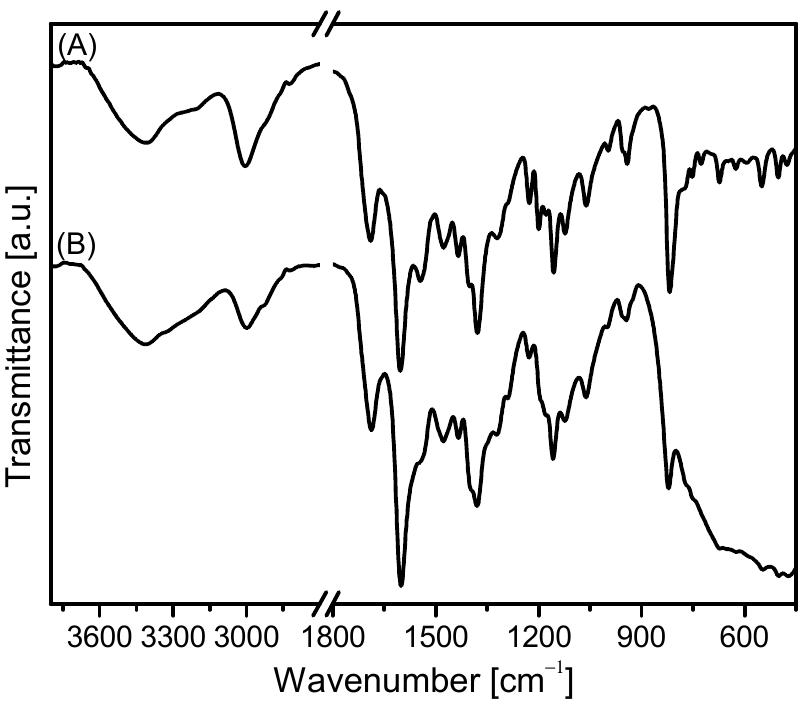
Figure 5. FTIR spectra of AO ( A ) before and ( B ) after photocatalytic degradation.